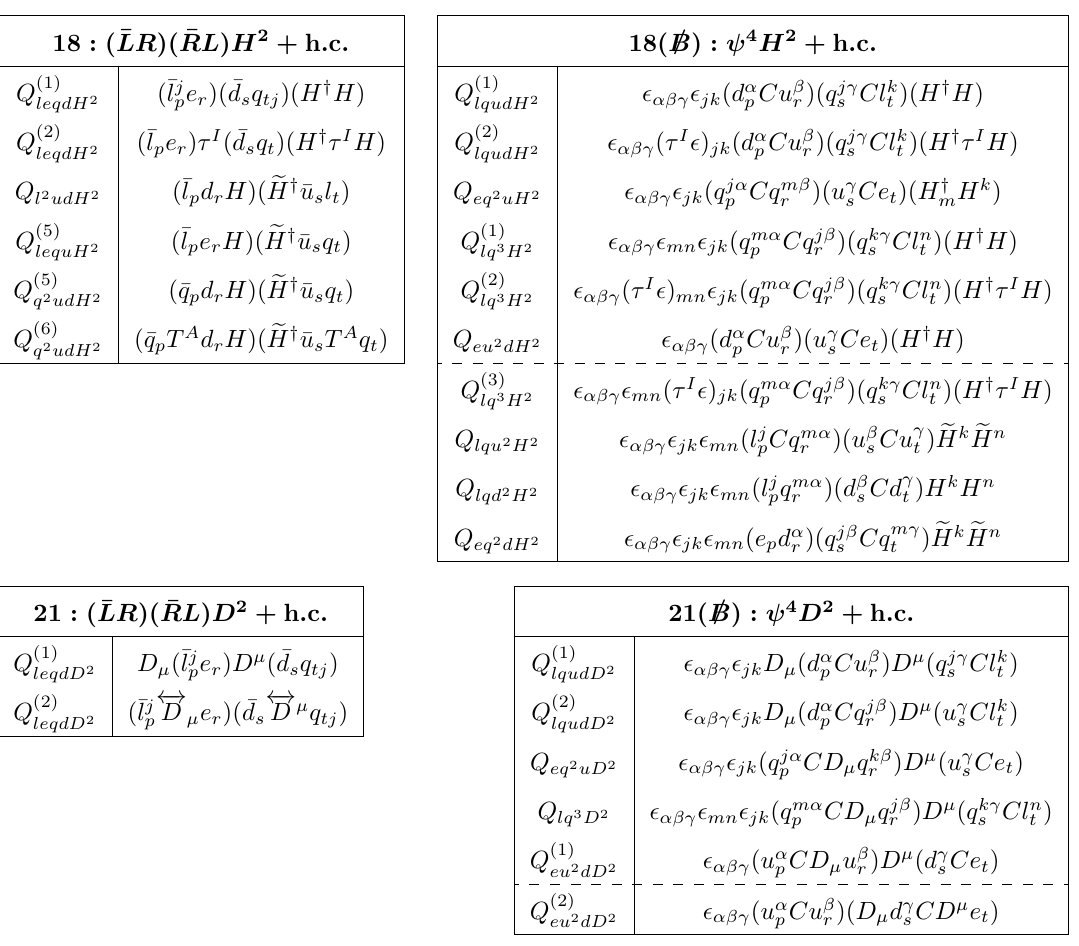
Table 10 . The dimension-8 operators of classes-18 and -21 whose fermionic content either has the chiral structure ((cid:22) LR )( (cid:22) RL ) or is baryon number violating. The subscripts p; r; s; t are weak-eigenstate indices. Operators below the dashed lines vanish when there is only one generation of